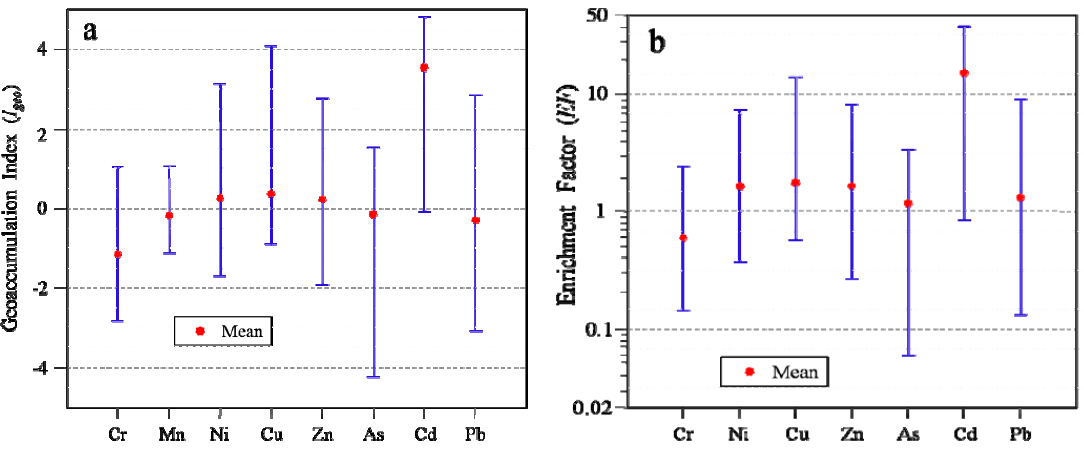
Figure 6. Mean, maximum and minimum values of ( a ) geoaccumulation index and ( b ) enrichment factor of HMs.